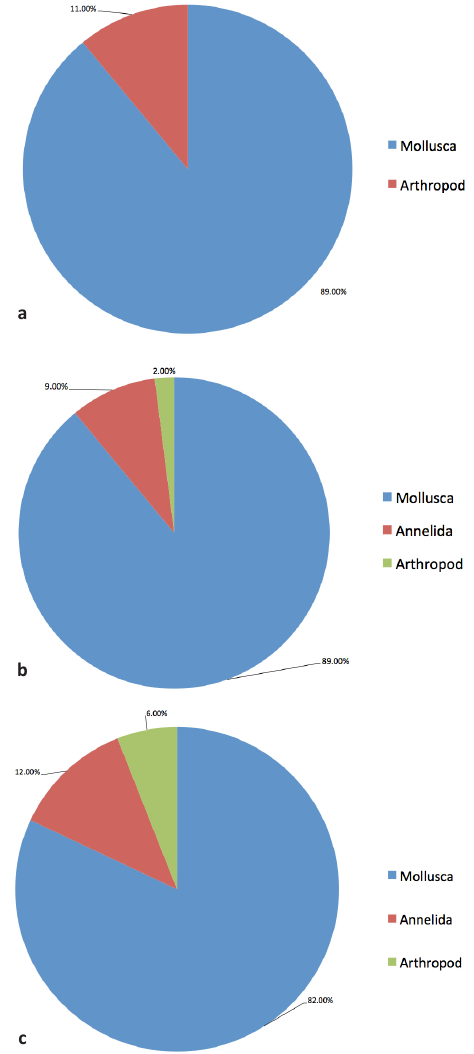
Figure 3. a, b, c - show the community structures of the benthic invertebrates of Ichamati at upper-, middle- and down-reaches, respectively.